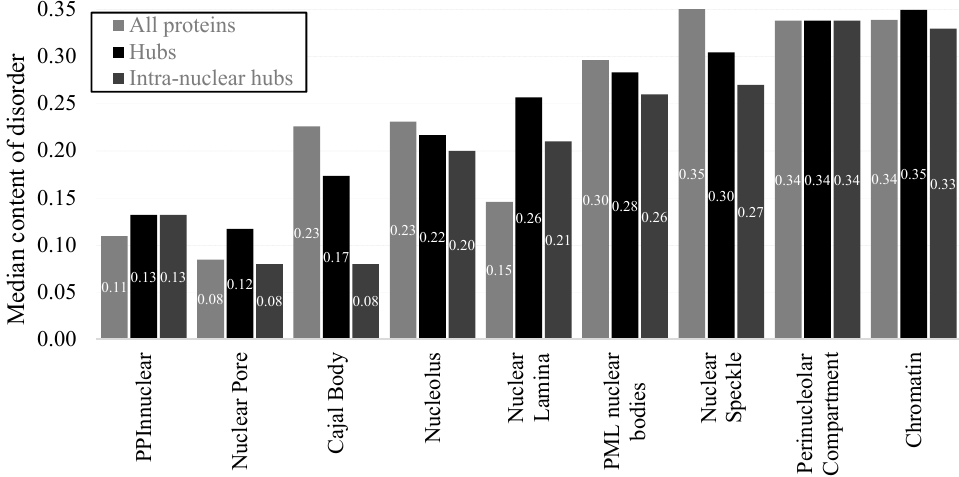
Figure 9. Median disorder content for all proteins (light gray bars), hubs (black bars), and intra-nuclear hubs (dark gray bars) from a given protein set including the non-nuclear proteins in the PPI NNUCLEAR dataset and proteins in the considered intra-nuclear compartment from the PPI NUCLEAR ap dataset. Disorder was annotated with the consensus of Espritz and IUPred.